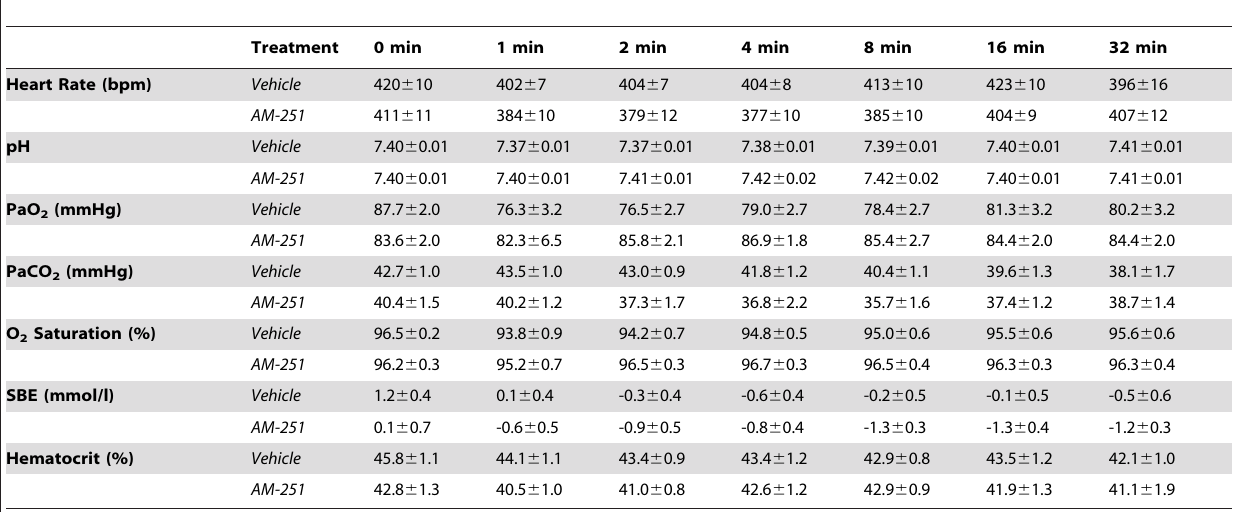
Table 1. Physiological parameters before (0 min) and at several timepoints after the administration of AM-251 or its